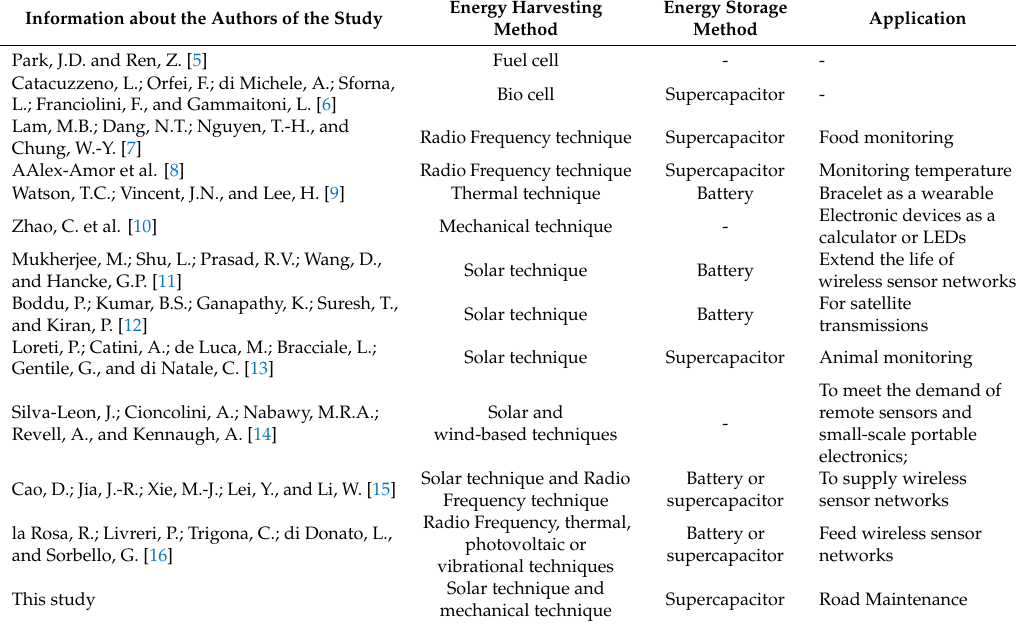
Table 1. Current methods of energy harvesting techniques and their applications.